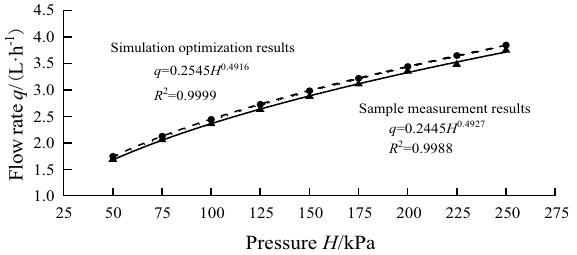
Figure 6. Comparison of flow-pressure curve between sample measurement results and simulation optimization results.